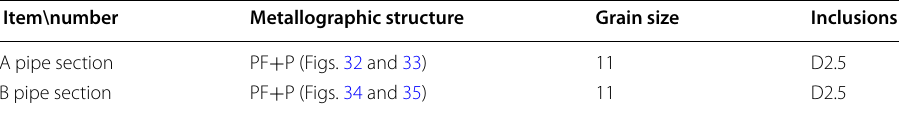
Table 13 Analysis results of microstructure of base metal Item\number Metallographic